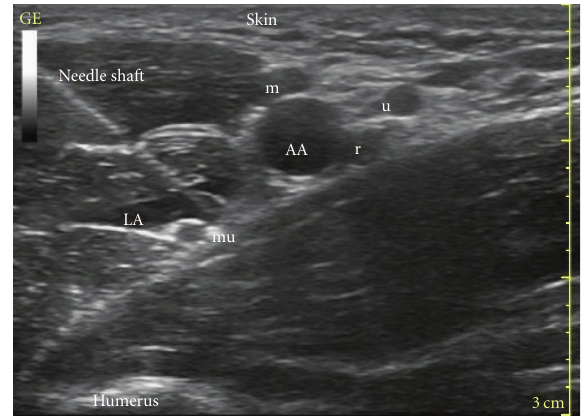
Figure 2: Ultrasound scan of axilla. AA: axillary artery, LA: local anaesthetics, r: radial nerve, mu: musculocutaneous nerve, m: median nerve, and u: ulnar nerve. This is an in-plane approach, with the whole length of the needle shaft visible under ultrasound.